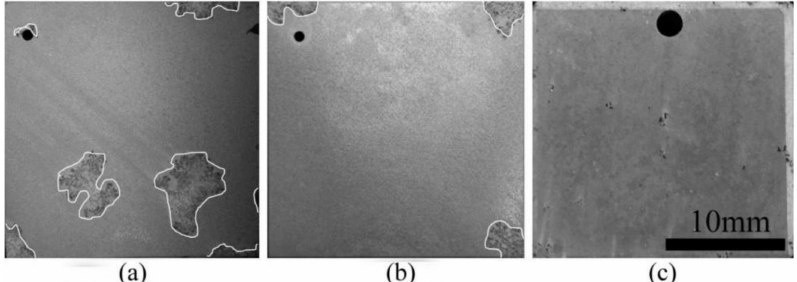
Figure 12. The result of the comparison with the state-of-the-art technology of the immersion test in 3.5% NaCl solution: ( a ) CO 2 _24 h sample immersed for 48 h, ( b ) CO 2 _2 h/pH 11.5_2 h sample immersed for 48 h, ( c ) CO 2 _3 MPa_0.5 h sample immersed for 48